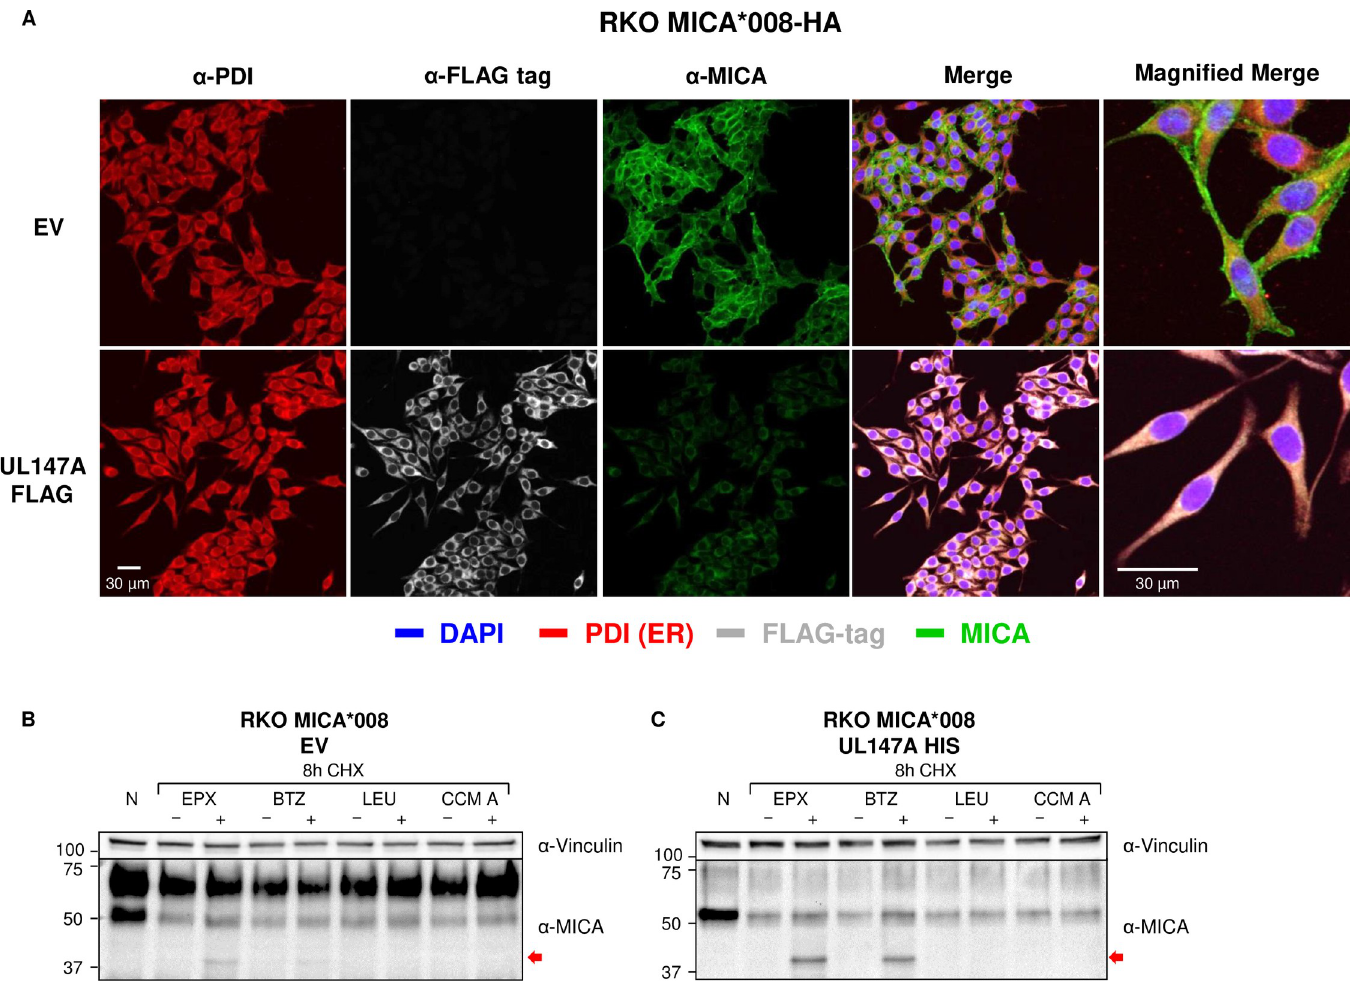
Fig 3. UL147A is an ER-resident protein which reduces surface MICA � 008 but spares ER-resident MICA � 008. (A) RKO MICA � 008-HA cells transduced with an EV or with UL147A-FLAG were grown on glass slides, fixed and stained with an anti-protein disulfide isomerase (PDI) antibody (ER marker; red), an anti-FLAG tag antibody (gray) and an anti-MICA antibody (green). Nuclei were stained with DAPI (blue). Images were captured by confocal microscopy. Representative of two independent experiments. (B-C) RKO-MICA � 008-HA cells expressing an EV (B) or N-terminally tagged UL147A (C) were left untreated (N), or incubated for 8 hours with the translation inhibitor cycloheximide (CHX, 50 μ g/ml), in combination with one of two lysosomal inhibitors: leupeptin (LEU, 100 μ g/ml) and concanamycin A (CCM A, 20 nM), or with one of two proteasomal inhibitors: epoxomicin (EPX, 8 μ M) and bortezomib (BTZ, 8 μ M). Each inhibitor was matched with an appropriate mock-treatment (DMSO or DDW). Following treatment, cells were lysed and blotted with anti-MICA. Anti-vinculin served as loading control. Representative of two independent